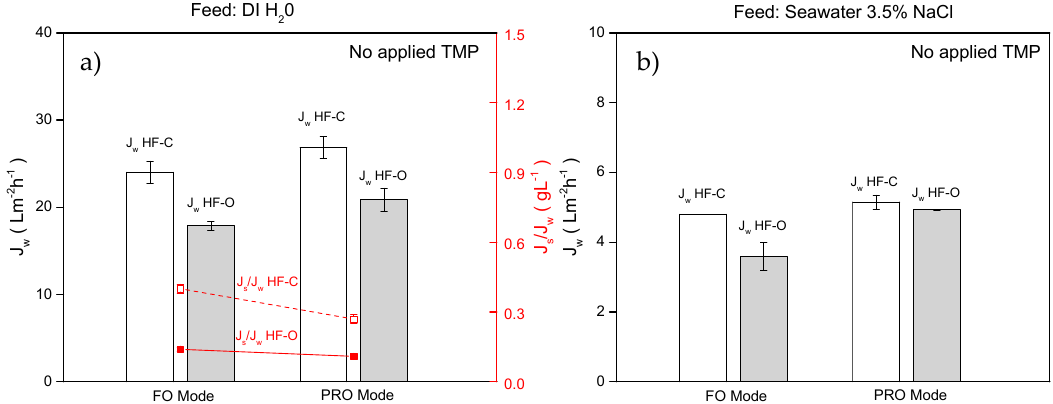
Figure 12. ( a ) J w and J s / J w for HF–C and HF–O modules operated in FO and PRO mode when DI Figure 12. a ) J w and J s /J w for HF–C and HF–O modules operated in FO and PRO mode when DI water water was used as an FS; ( b ) J w for HF–C and HF–O modules operated in FO and PRO mode when was used as an FS; b ) J w for HF–C and HF–O modules operated in FO and PRO mode when 3.5% 3.5% NaCl was used as an FS. Feed flow rate was 100 L · h − 1 , draw flow rate was 25 L · h − 1 , and draw NaCl was used as an FS. Feed flow rate was 100 L·h − 1 , draw flow rate was 25 L·h − 1 , and draw concentration was 1 M NaCl (n = concentration was 1 M NaCl (n = 2).